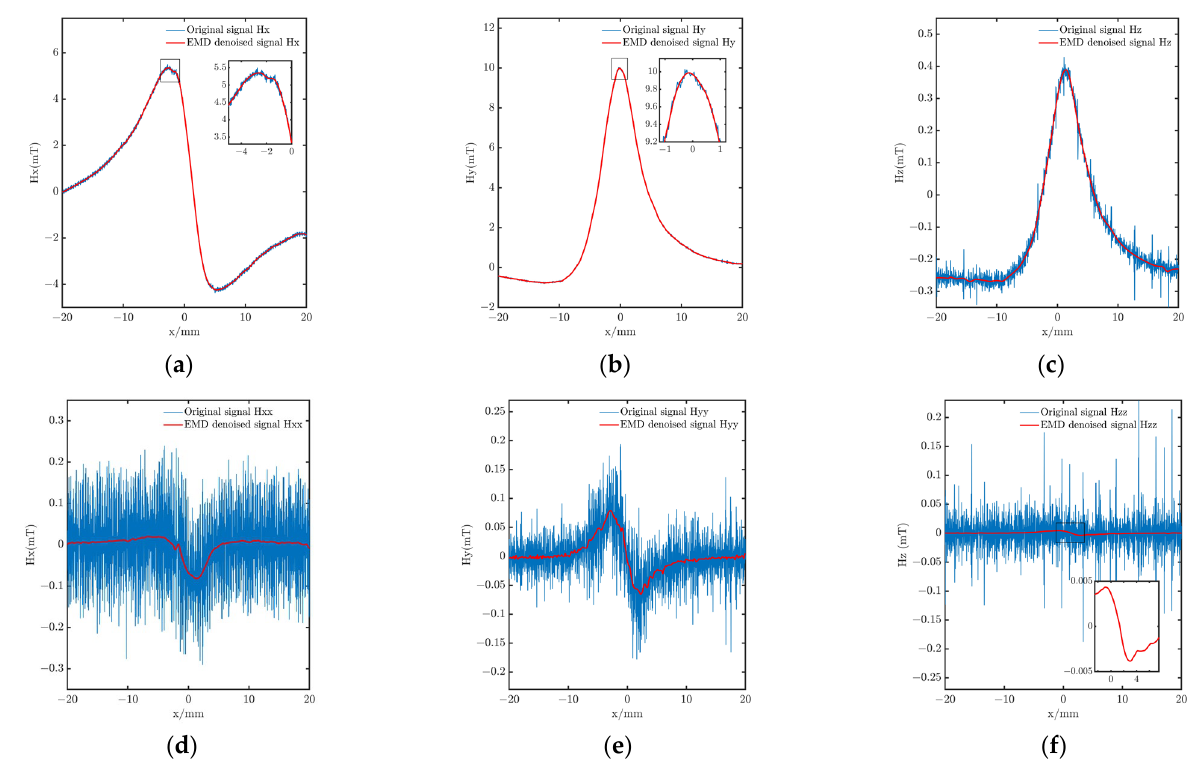
Figure 7. Comparative diagram of EMD denoising effect. ( a ) Comparison of normal component signals. ( b ) Comparison of tangential component signals. ( c ) Comparison of horizontal component signals. ( d ) Comparison of gradient values of normal component signal. ( e ) Comparison of gradient values of tangential component signal. ( f ) Comparison of gradient values of horizontal component signal.